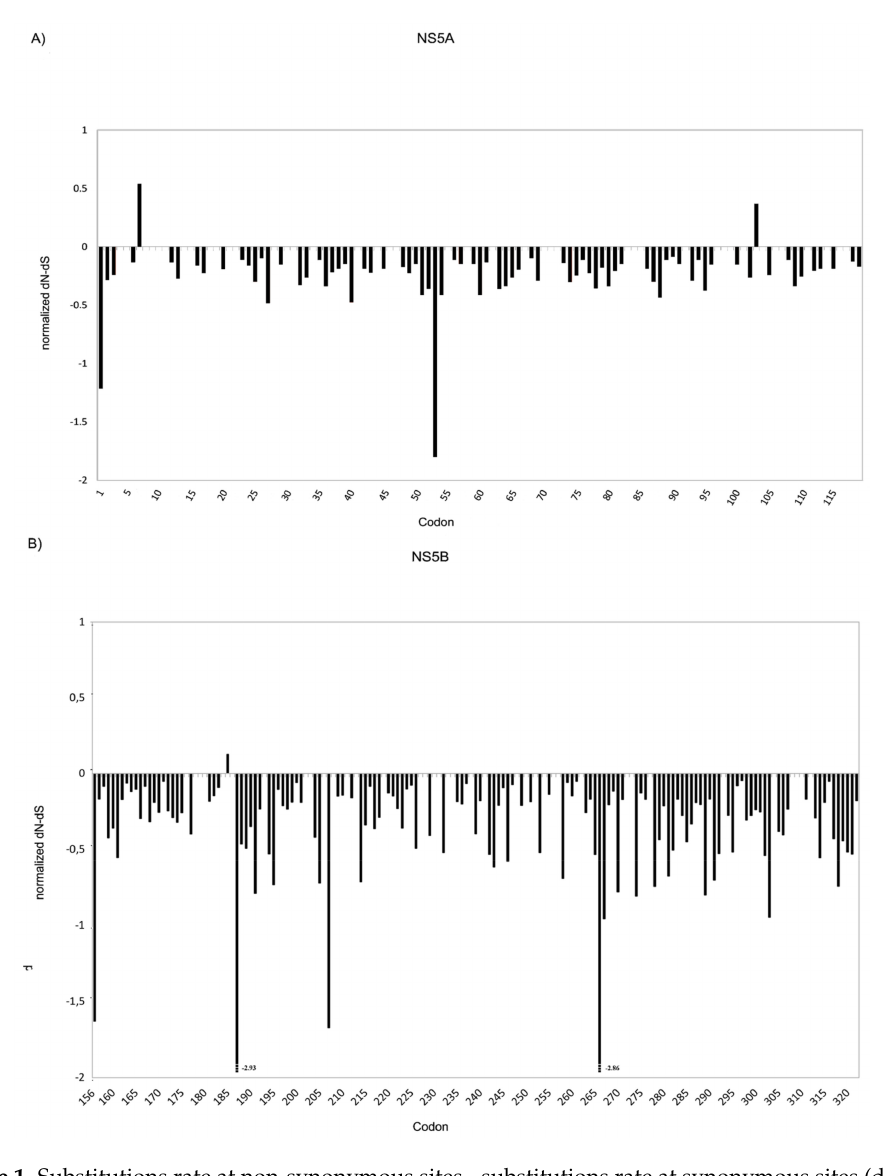
Figure 1. Substitutions rate at non-synonymous sites - substitutions rate at synonymous sites (dN-dS) in HCV GT3a sequences worldwide. The graphs represent dN-dS vs. each codon for: NS5A ( A ); and NS5B ( B ) of HCV GT3a sequences from the Los Alamos